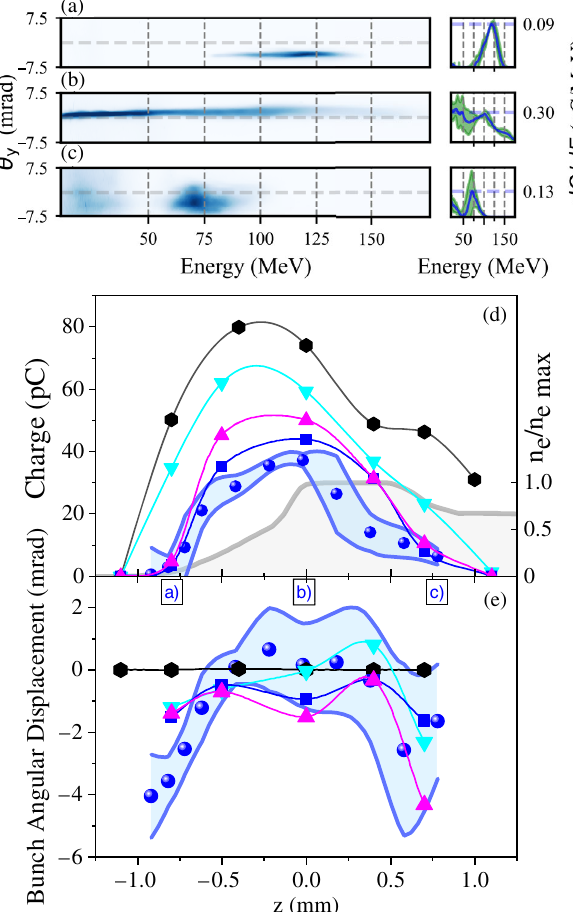
FIG. 7. Representative experimental electron spectra within (cid:2) 7 . 5 mrad window around the laser axis between 11 and 175 MeV, corresponding to laser focal positions along the longitudinal spatial axis, z , (a) preplateau: z ¼ − 0 . 8 mm, (b) peri- plateau: z ¼ 0 mm, and (c) postplateau: z ¼ 0 . 8 mm for the LE case and 1bFPS AO settings; (d) total charge within a (cid:2) 4 mrad of the electron bunch peak spatial location, and (e) electron bunch peak displacement from laser axis, defined as zero angular displacement, are shown as blue circles as functions of position along the laser axis. Simulated results for n e ¼ 6 . 7 × 10 18 cm − 3 and a 0 ¼ 2 . 15 are plotted as black hexagons for a Gaussian laser bunch and realistic 1bFPS sim laser as blue squares; for comparison n e ¼ 7 . 5 × 10 18 cm − 3 and a 0 ¼ 2 . 15 are indicated by cyan down triangles ( a 0 ¼ 2 . 0 by magenta up triangles). Plasma density profile is illustrated by the gray line. Errors are given by the standard deviation of the values for both parameters and dQ=dE from consecutive